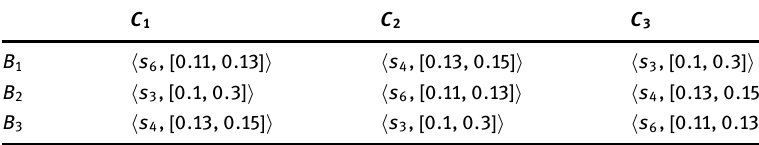
Table 9: Intuitionistic Linguistic Fuzzy Decision Matrix.